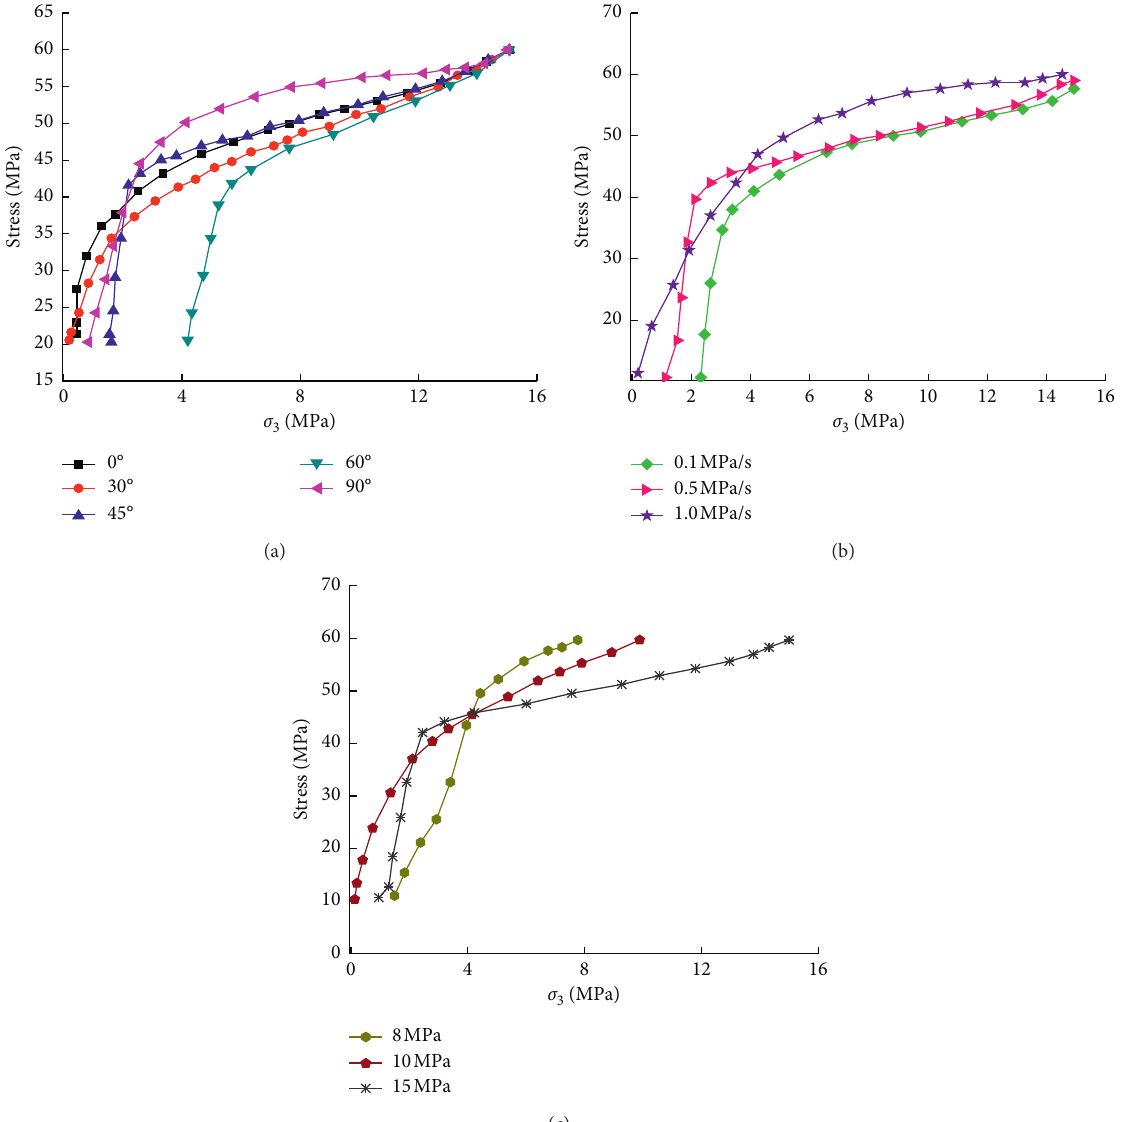
Figure 6: ( σ − σ ) − σ curves of cracked specimens under axial unloading and radial unloading conditions. (a) Stress- σ 3 . (b) Effect of 1 3 3 unloading rate of confining pressure. (c) Effect of initial confining